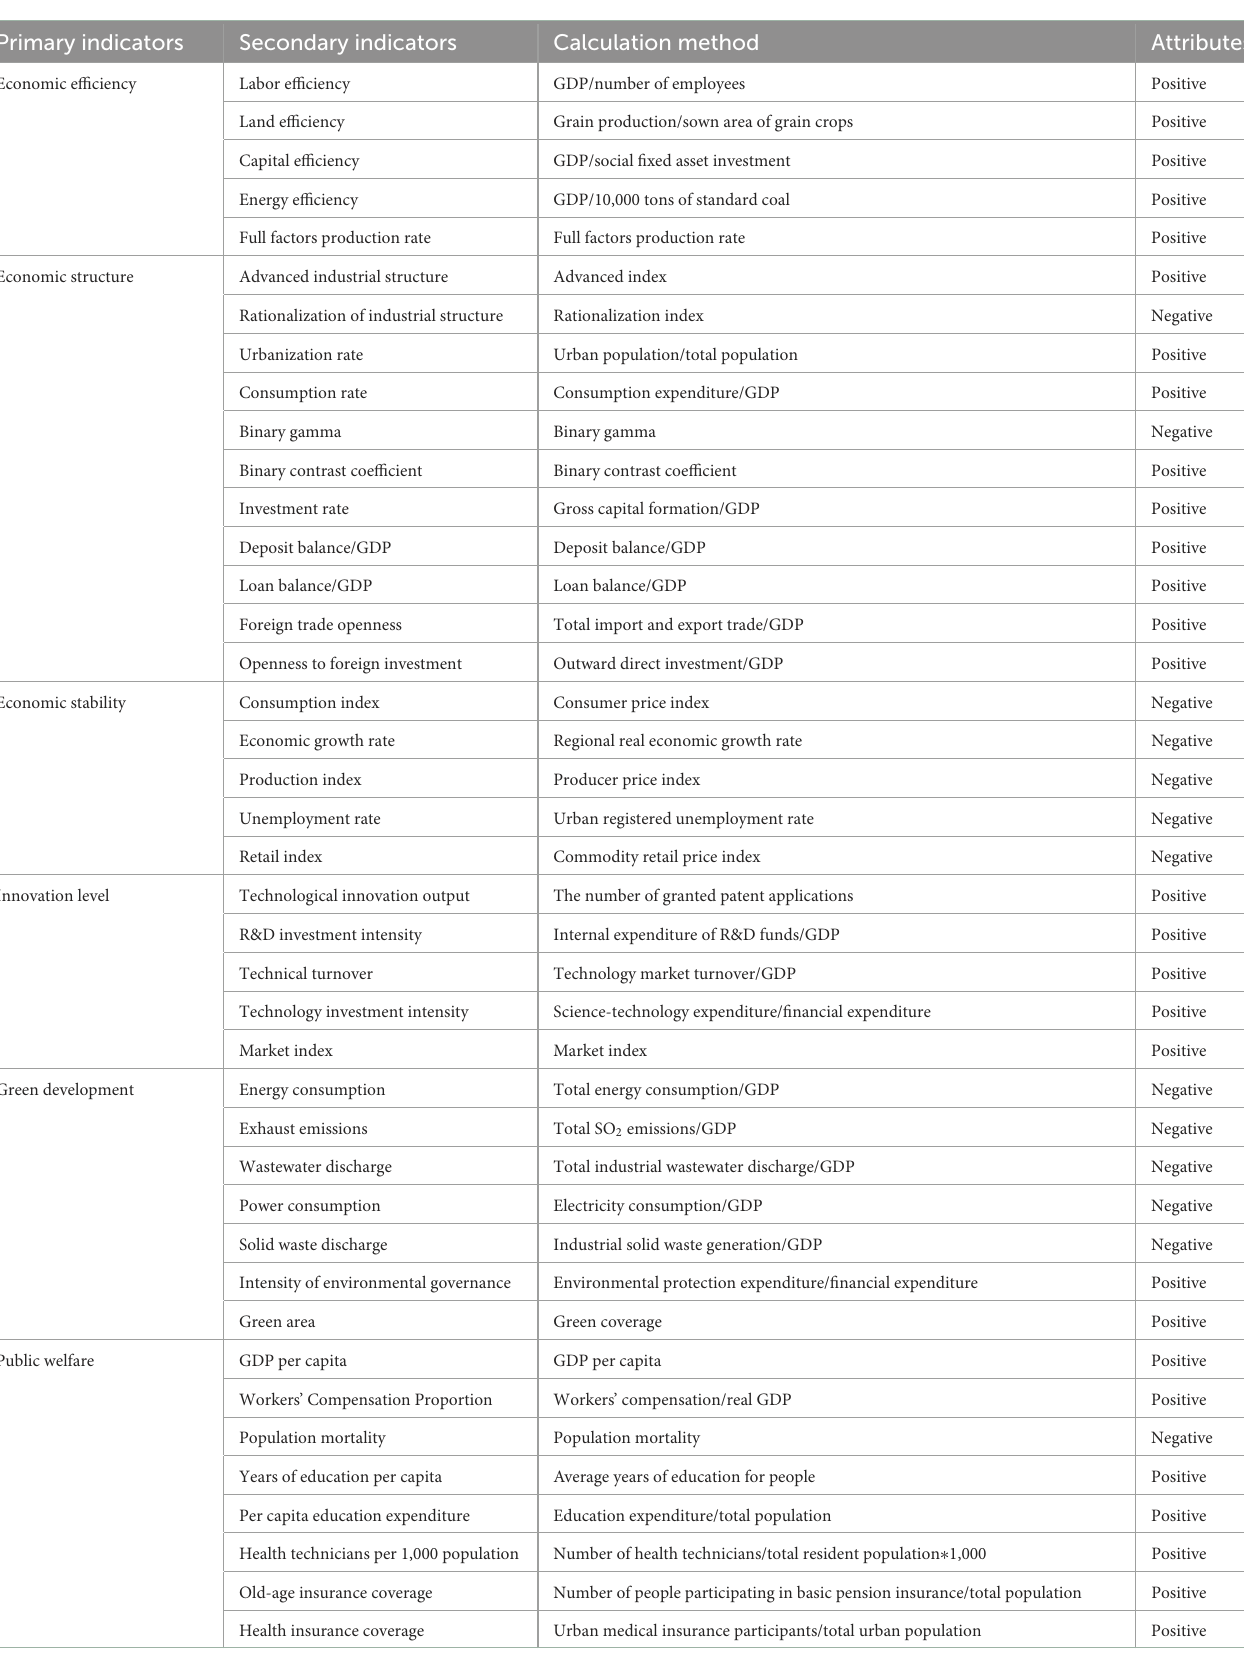
TABLE 1 Comprehensive indicator system for high-quality economic